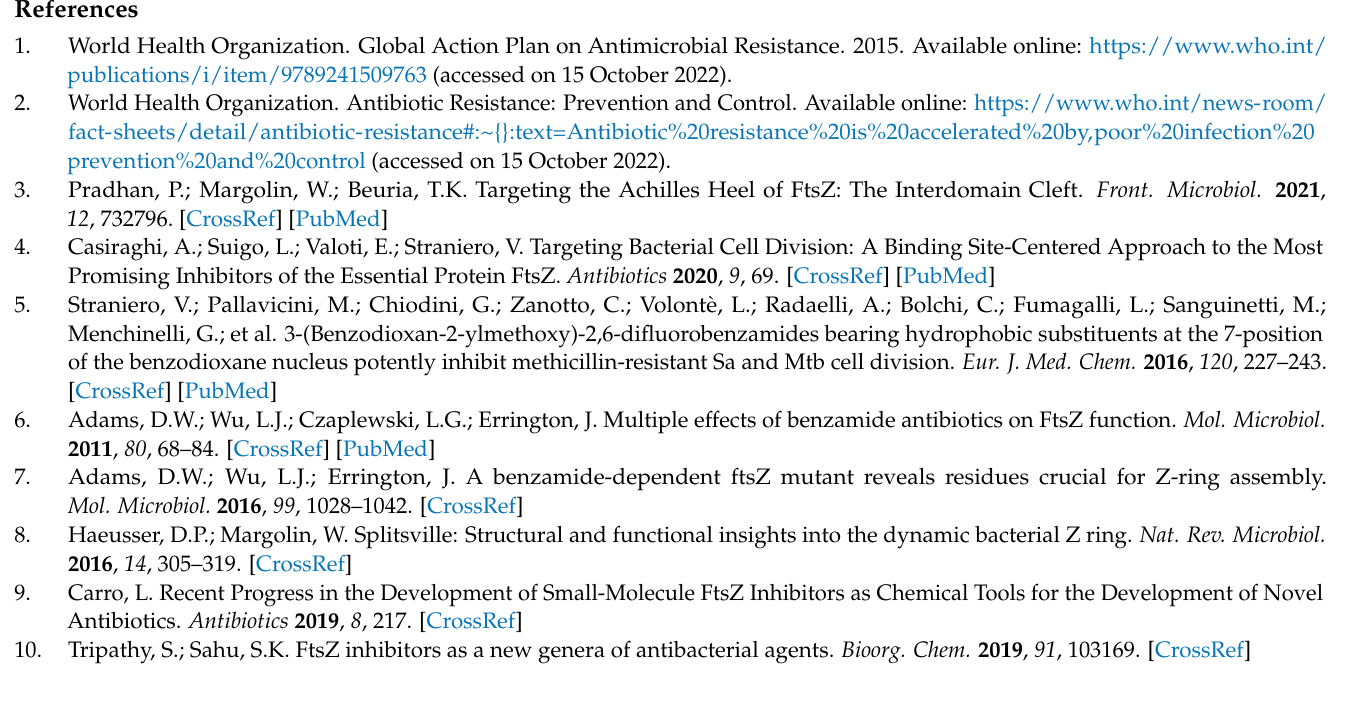
Figure S3: Copy of HRMS spectrum; Figure S4: Copy of Elemental Composition Report; Com- pound 1b threo ; Figure S5: Copy of 1 H-NMR spectrum in DMSO-d 6 ; Figure S6: Copy of 13 C-NMR spectrum in DMSO-d 6 ; Figure S7: Copy of HRMS spectrum; and Figure S8: Copy of Elemental Composition